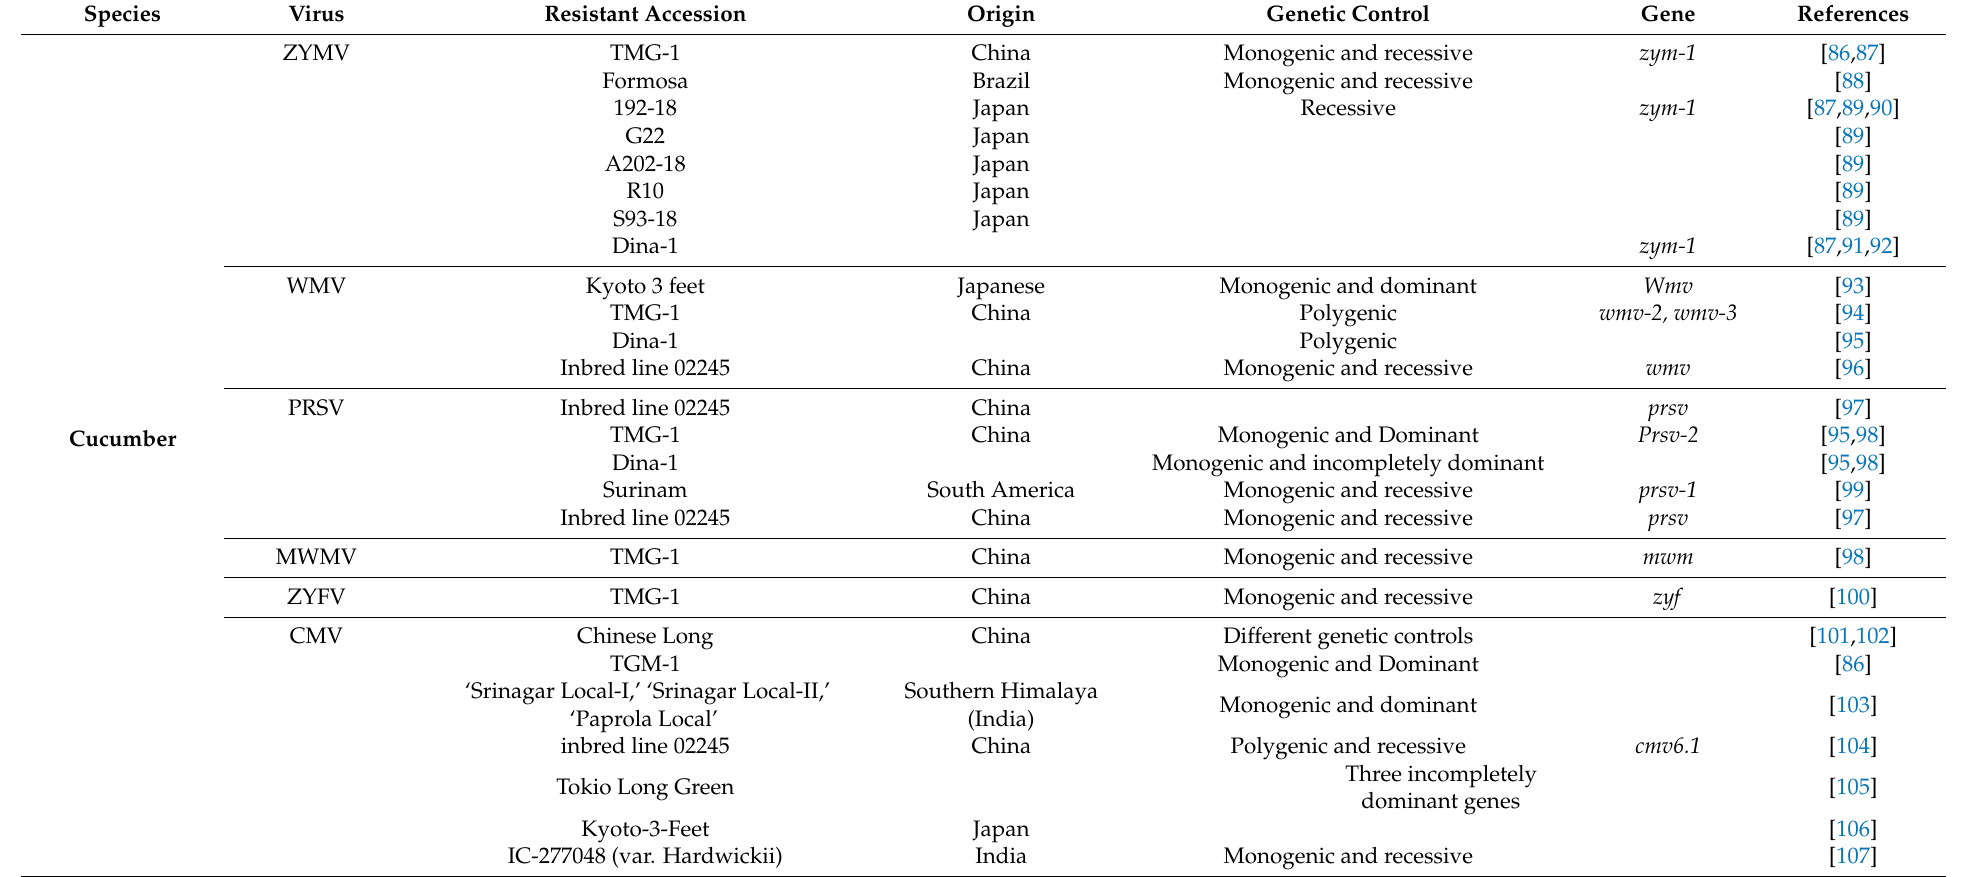
Table 2. Genetic resources for resistance to viruses in C. sativus